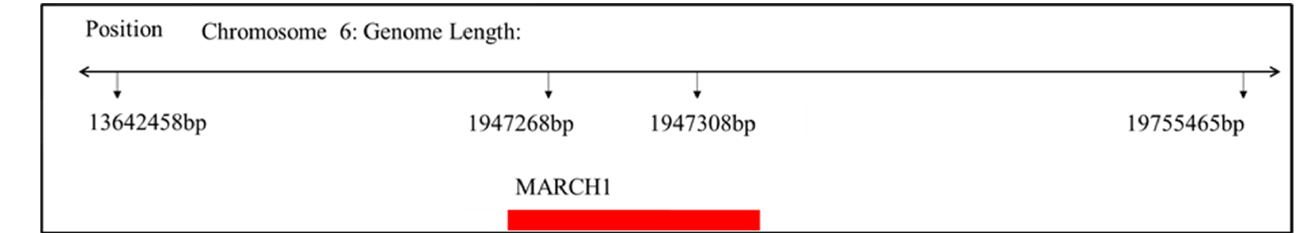
Figure 1. Length of marker position of a gene (MARCH1) and Chromosome 6 (https://www.animalgenome.org/cgi-bin/QTLdb/BT/search accessed on 29 January 2022).